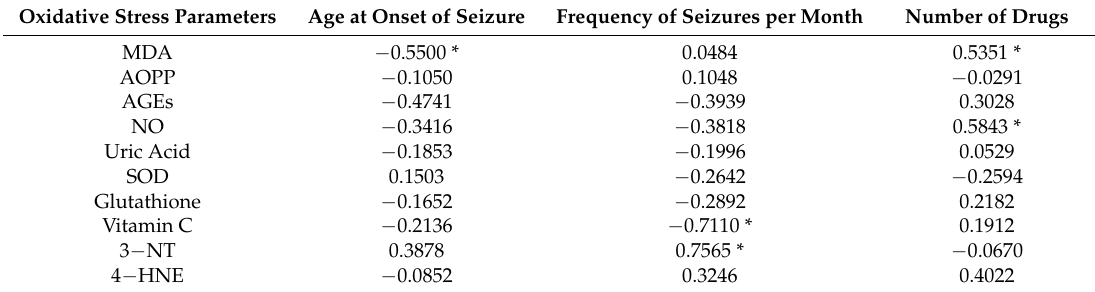
Table 2. Correlation of MDA, NO, Vvtamin C and 3-NT with the time evolution of seizures, the frequency of seizures per month and the number of drugs taken by a